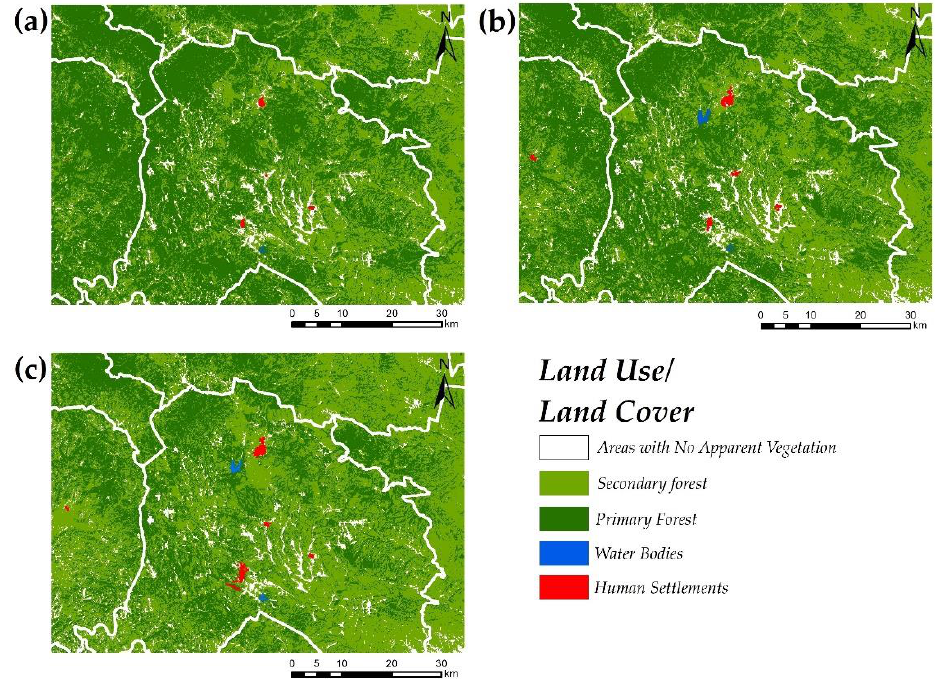
Figure 3. Land use/land cover classification maps for ( a ) 1990; ( b ) 2005 and ( c ) 2017. Table 3. Accuracy of the land use/land cover classification. Land Use/Land